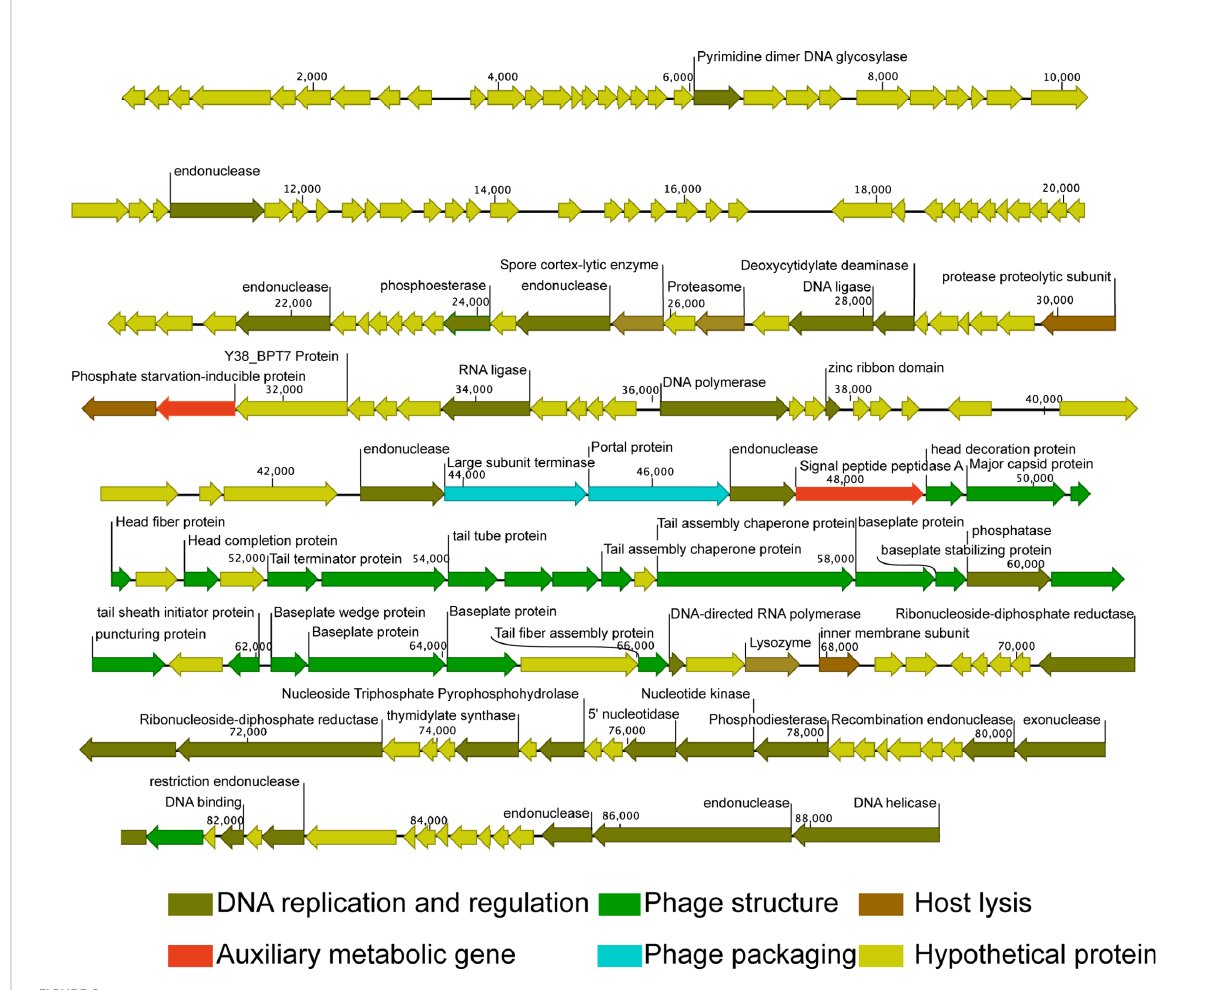
FIGURE 2 Genome map of Pseudomonas phage vB_PsaP_M1. Putative functional categories were de fi ned according to annotation and are represented by different colors. The length of each arrow represents the length of each